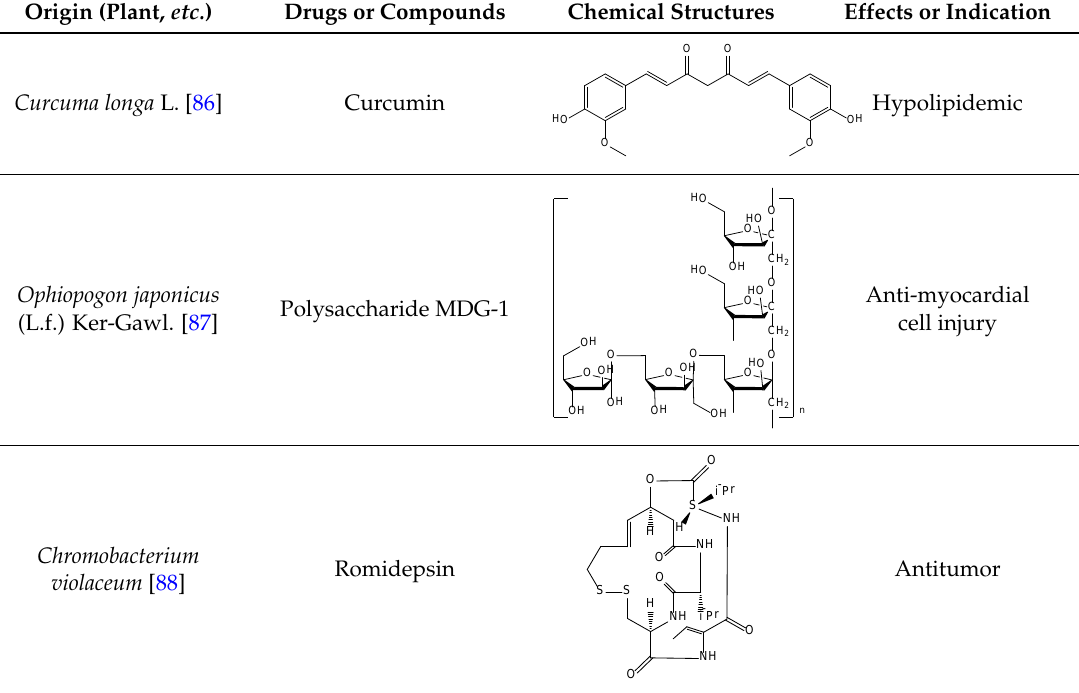
Origin (Plant, etc.